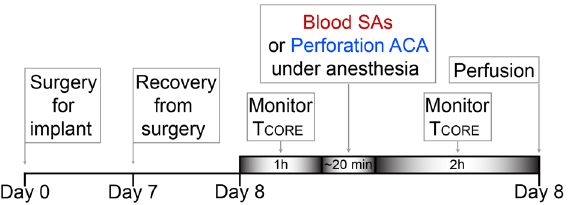
Figure 4. Schedule of experimental procedures. Timeline of the experimental protocol for (1) injection of blood into the subarachnoid space (SAs) and (2) perforation of the anterior cerebral artery (ACA). Rats underwent surgery for implantation of temperature recording devices on Day 0. On day 8, following 7 days of recovery from surgery, one hour of baseline core temperatures were recorded at 15 min intervals, followed by the procedure for blood injection into the SAs or perforation of the ACA. Core temperature was then monitored for 2 h, before perfusion, to assess the occurrence of